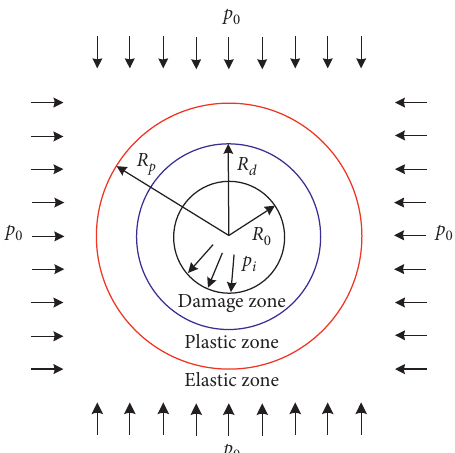
Figure 1: Mechanical model of the circular tunnel.